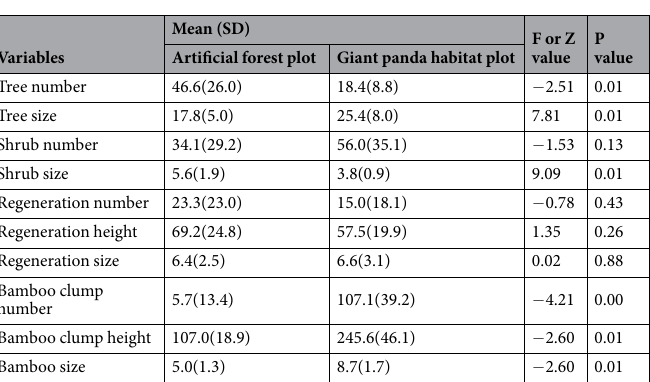
Table 3. Community structure of artificial forest plot and giant panda habitat plot.